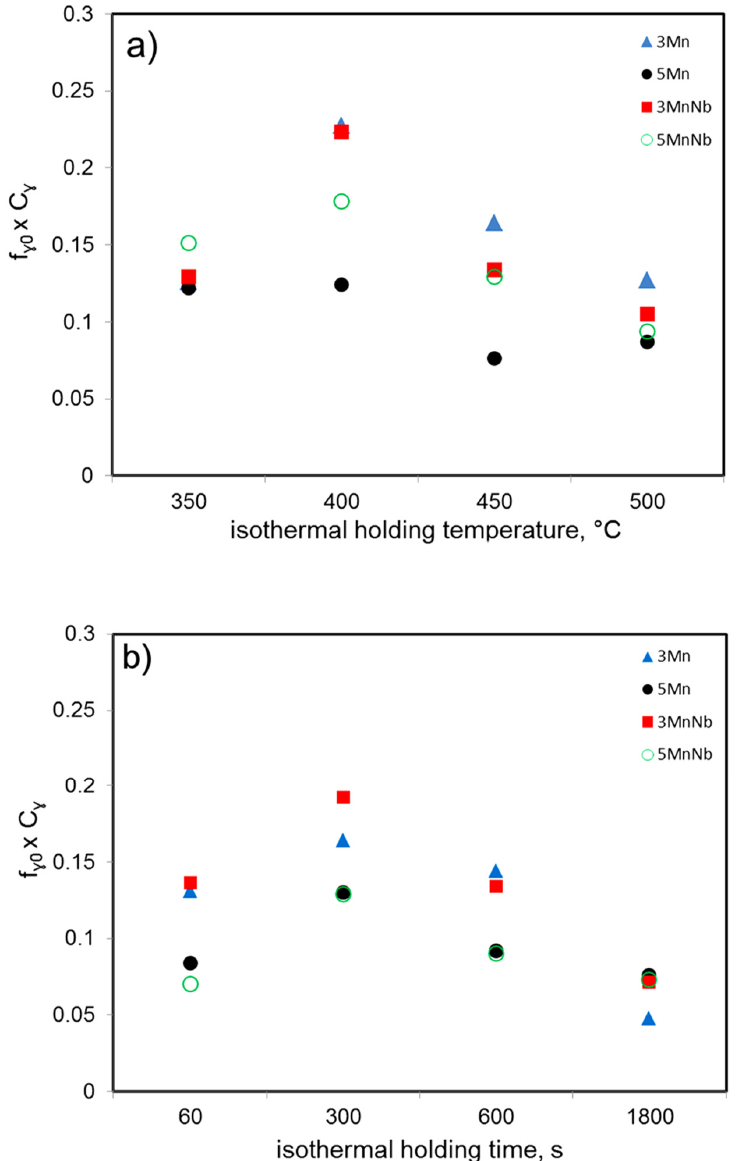
Figure 5. ( a ) Influence of isothermal holding temperature on the product of the retained austenite amount and its carbon content for the steels treated for 300 s; ( b ) Influence of isothermal holding time at 450 °C on the product of the retained austenite amount and its carbon content.